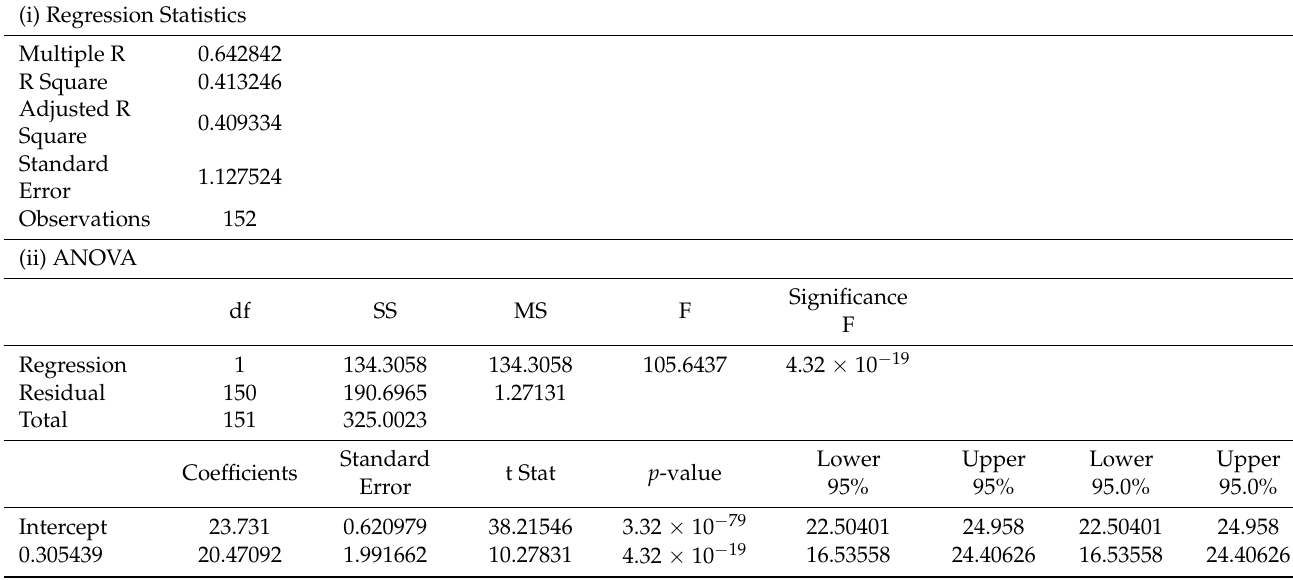
Table A6. Regression Statistics between LST and NDBI for